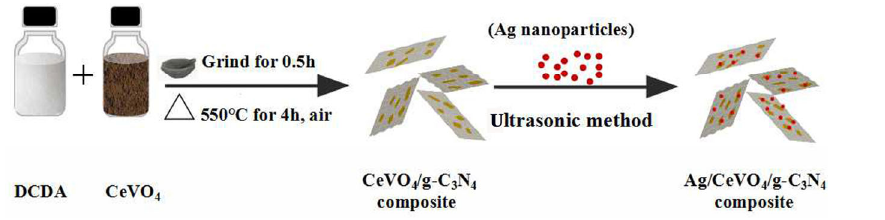
Fig. 1 Schematic diagram of preparation of Ag/CeVO 4 /g-C 3 N 4 .